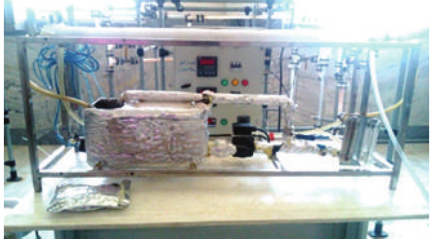
Figure 3: Experimental setup.